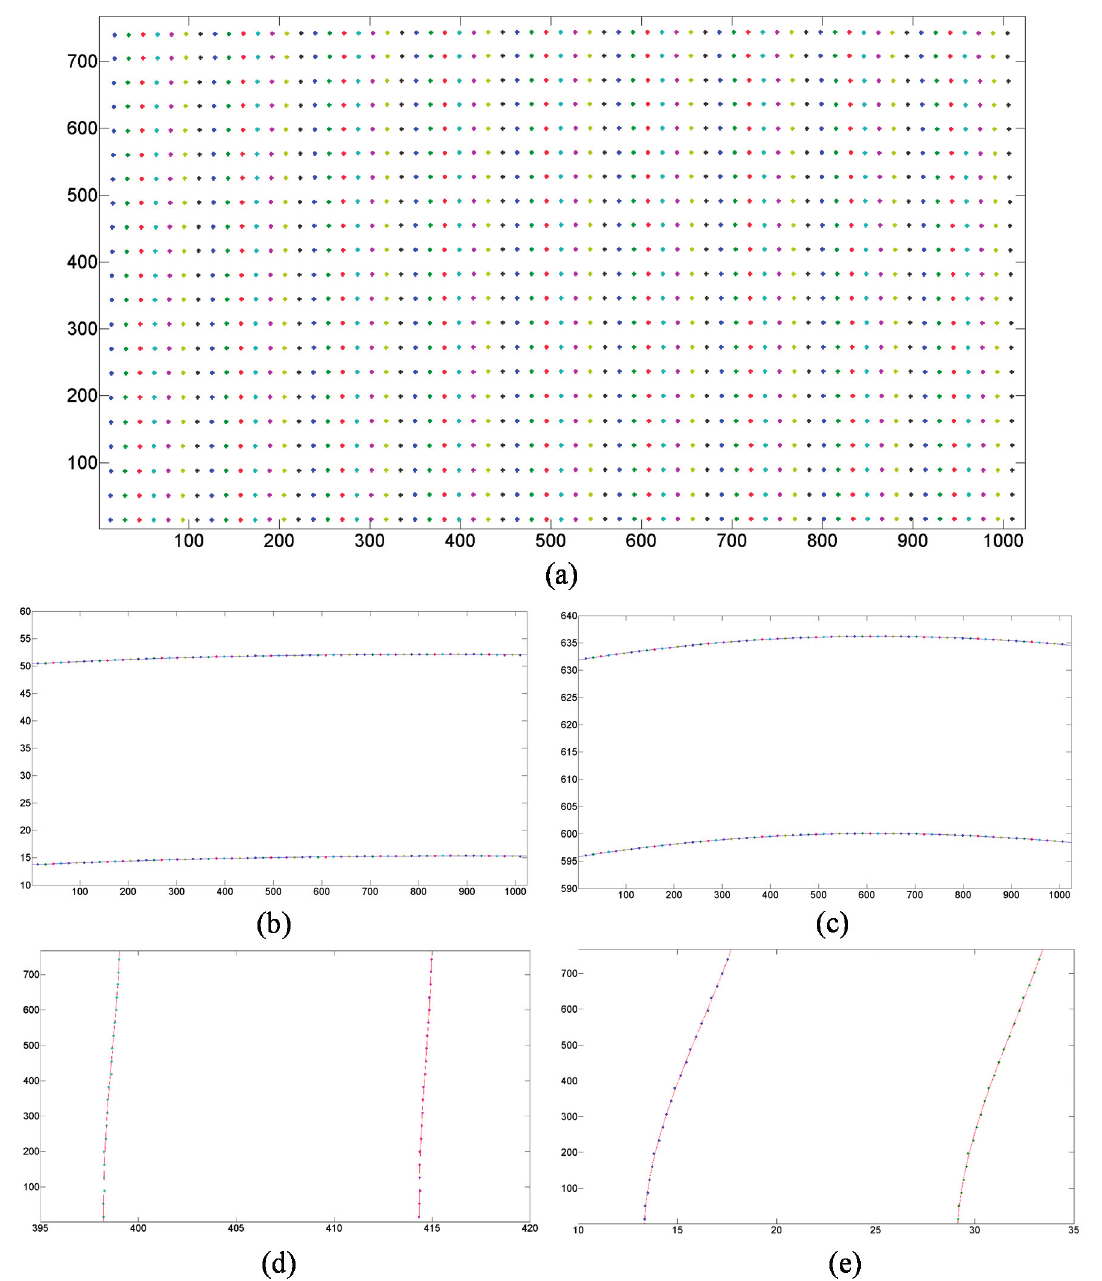
Figure 7. Results after obtaining VMPs’ coordinates and polynomial fitting (unit: pixel). ( a ) The points on the object plane corresponding to the VMPs on the image plane; ( b ) and ( c ) give the partial enlarged views of the Axis Y; ( d , e ) give the partial enlarged views of the Axis X. The curves indicate polynomial curve of these measuring